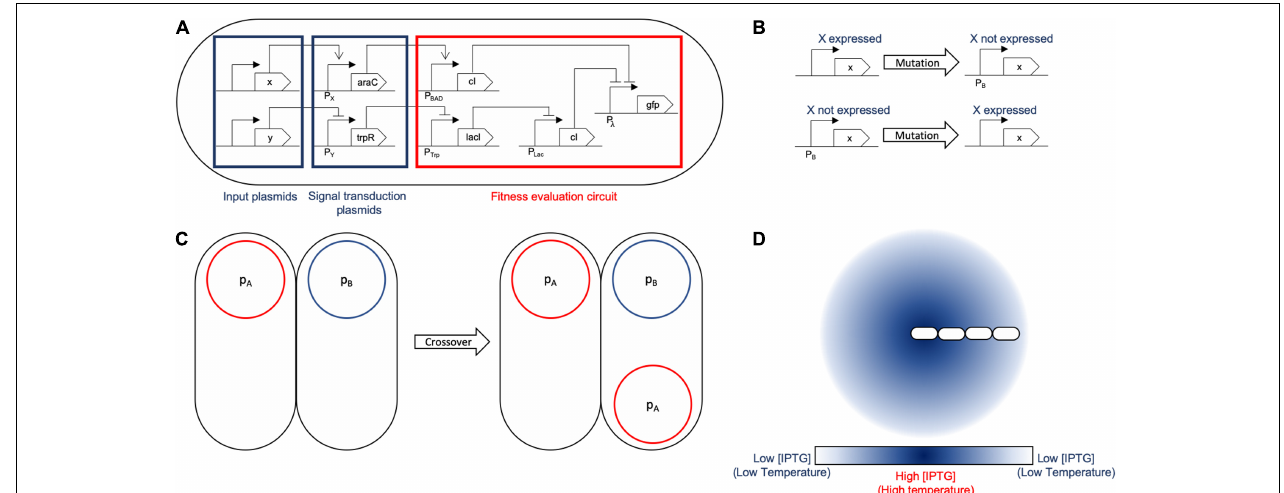
FIGURE 3 | General logic mapping for SA and SGA. (A) General gene network mapping for the MH framework. A three-tier design is proposed: the first tier are conjugative plasmids (x and y) holding input proteins that are used by the fitness function to assess the quality of the solution. A second tier is a transition one in which the input signals are transduced into standard proteins (araC and trpR) for their evaluation. At this stage, the set of proteins which should be absent express araC to induce cI in the next tier. This is due to the fact that if any of those proteins is present, it activates cI, making the solution sub-optimal. Conversely, the set of proteins that should be present inhibit the expression of trpR, forcing the presence of all of them. If all of them are present, the following inhibition chain fails to repress GFP, evaluating correctly for those plasmids. Finally, tier three is the evaluation circuit in which the input signals are checked against their respective set (if they need to be present, absent, or it is indifferent if they are present). This part of the circuit acts works as two inverters feeding an OR gate (P λ ): the first one (stemming from the x protein branch) evaluates for plasmids that should not be present and activates cI to block expression of GFP. The branch corresponding to the y protein evaluates for plasmids that should be present by using lacI to inhibit the expression of cI, allowing for GFP expression if all the required plasmids of that branch are present. If either condition fails, GFP will not be expressed, meaning it is not an optimal solution. However, if said evaluation is successful, it triggers GFP expression. That action may be replaced by any other such as increased conjugation rate or lower division times. (B) The mutation operation for SGA acts on the expression of a specific protein in the design, changing the solution to evaluate. The mutation rate parameter for SGA maps directly to the mutation rate configured in the simulation. This operation accounts for global search in terms of the solution exploration. (C) Crossover is a recombination operation that we mapped to bacterial conjugation. Part of a foreign solution is integrated to the current one. In our mapping, we individualized a single protein to be held by a unique plasmid, therefore mobilizing a single protein between solutions for recombination. Conjugation rate is the parameter that accounts for the SGA crossover rate parameter. (D) SA is largely based on a temperature decrease function: we use environmental signals (such as aTc or IPTG) as its representation. The temperature is associated to the signal concentration at a given location. The decrease is achieved by the shoving mechanical effects of the cell colony: the center of the colony experiences a greater temperature that the outer sections.